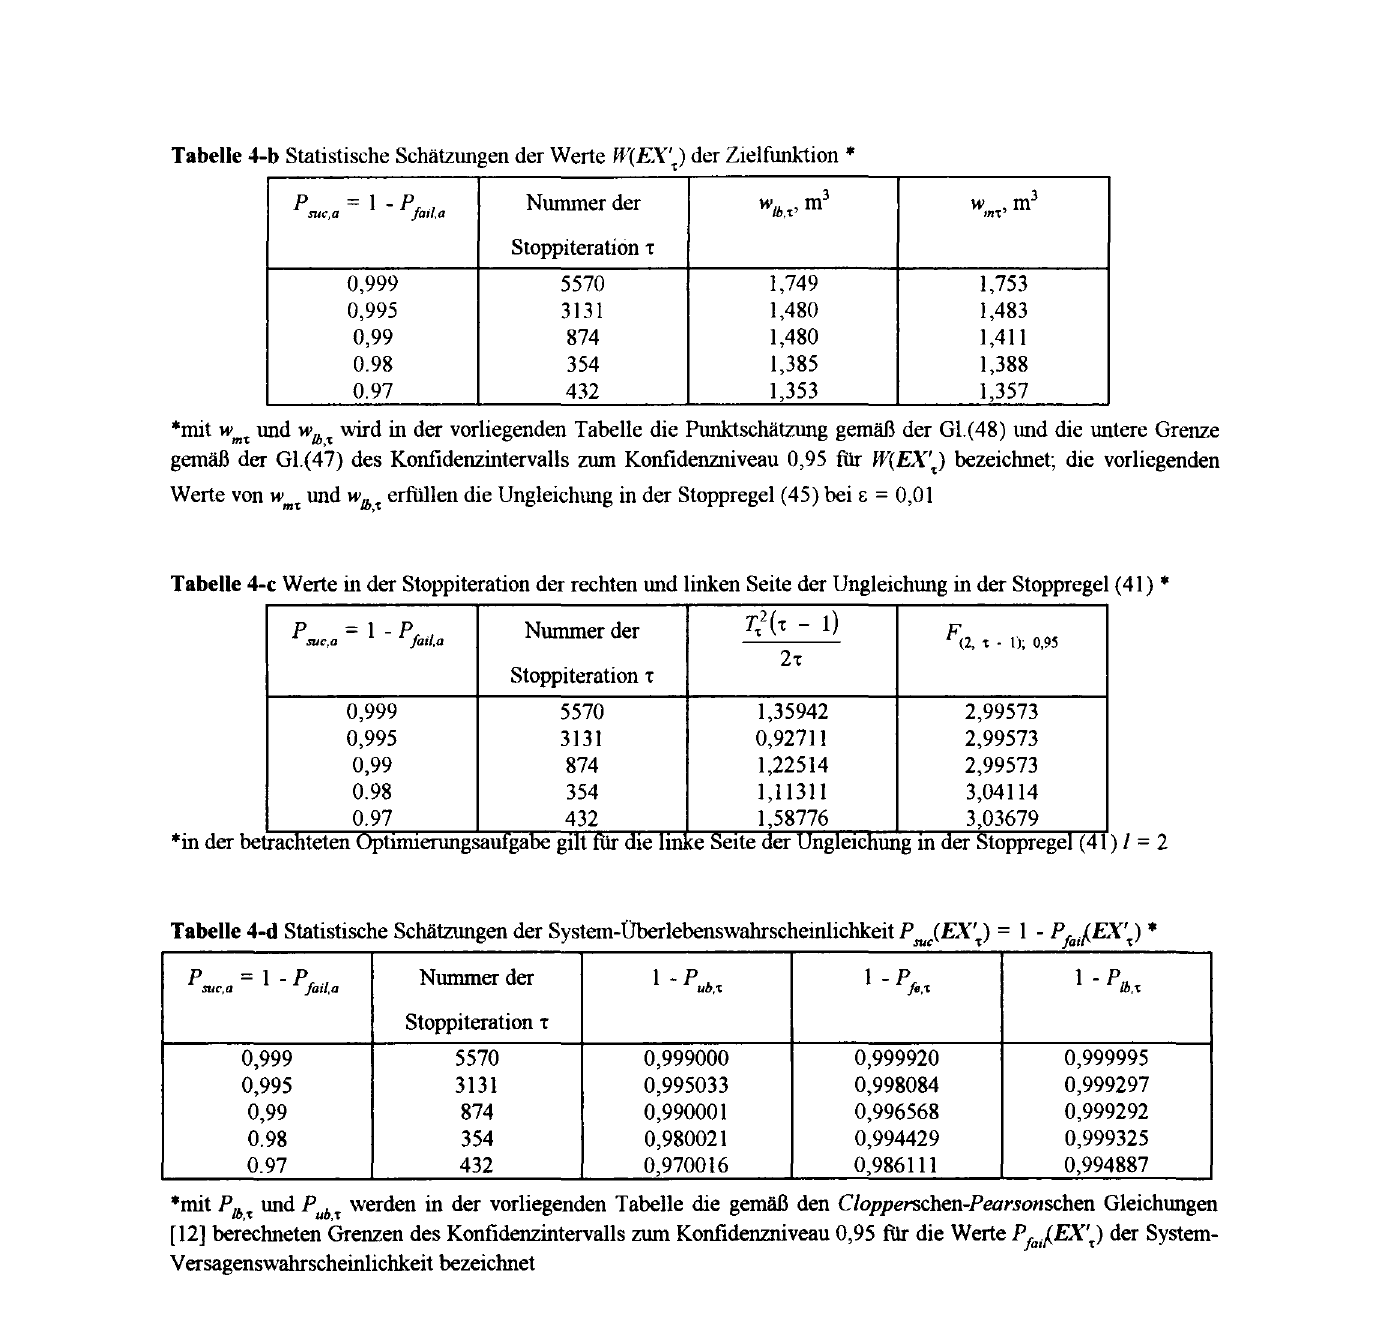
Tabelle 4-d Statistische Schiitzlillgen der System-Ober1ebenswahrscheinlichkeit P su/EX'.) = 1 - P